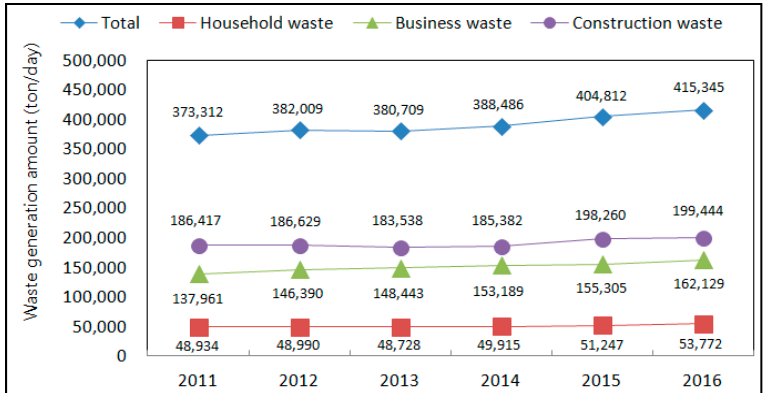
Figure 1. Changes in the waste material volume in Korea [1].